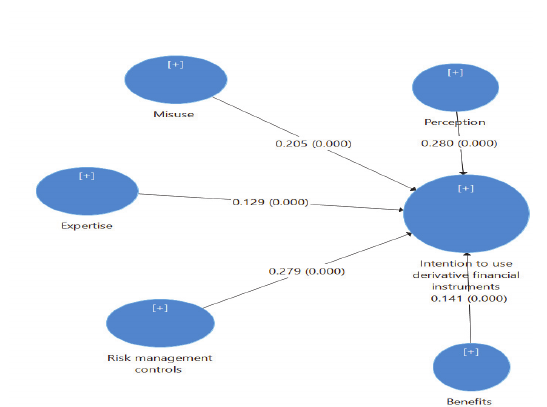
Fig. 5. Results of multi-group analysis with college-level group